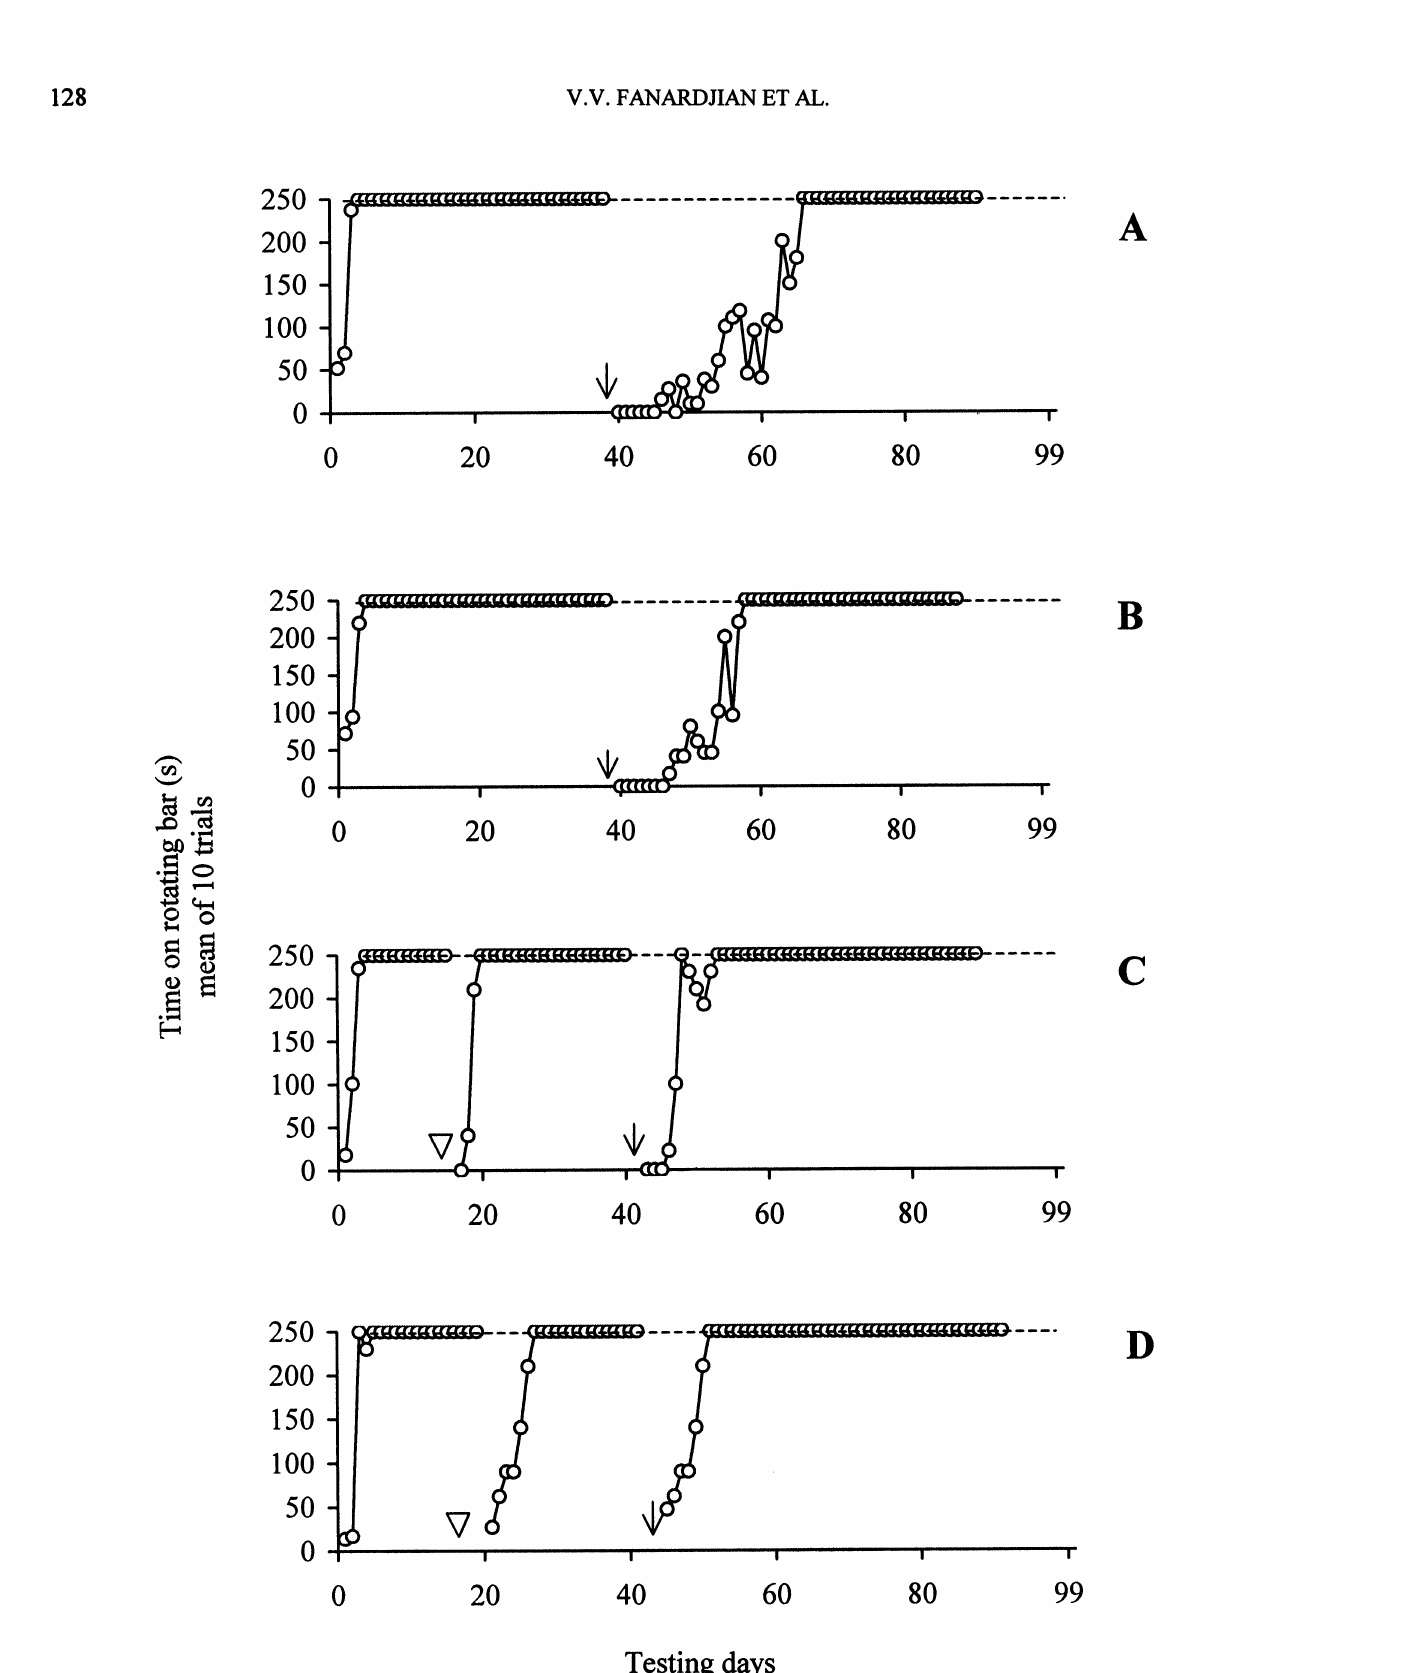
Fig. 4" Effects of transection of the dorsolateral ftmiculus and chemical lesion of RN on performance of learned instrumental reflexes in four rats (A, B, C, D). A and B" RN alone was lesioned. C and D: RN lesion was made after transection of the DLF. The designations are the same as those in Fig.